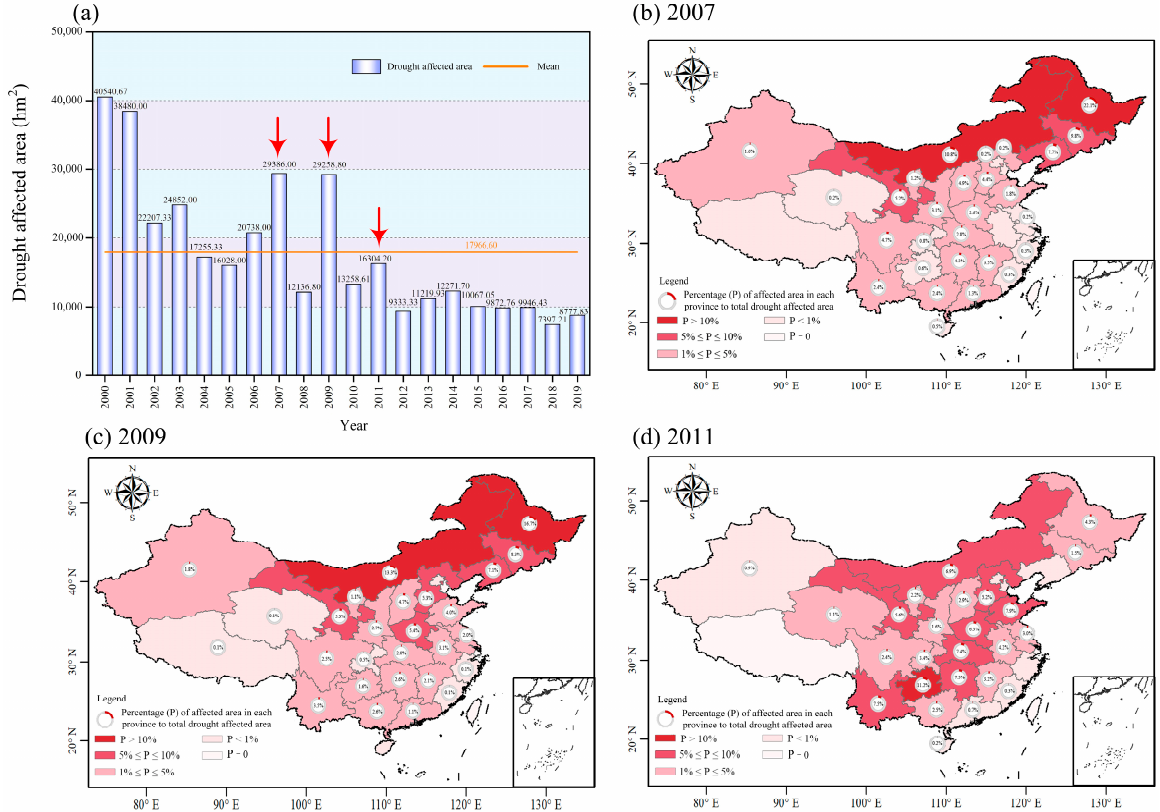
Figure 10. ( a ) Annual drought area in China during 2000–2019. ( b )–( d ) The percentage of affected area in each province to total drought affected area in China in 2007, 2009, and 2011, respectively.